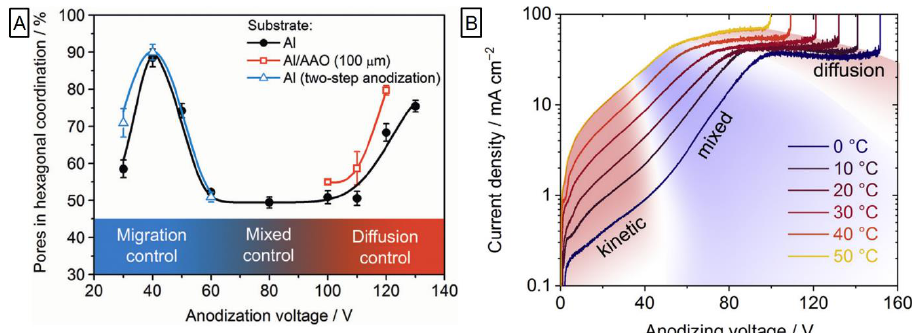
Figure 6. Anodization potential influence on degree of self-ordered growth and voltage/temperature dependent formation kinetics of 0.3 M H 2 C 2 O 4 anodization of aluminum. ( A ) Dependence of pore ordering degree during formation of alumina structure with highlighted regions of different growth kinetics. Reprinted (adapted) with permission from [111]. Copyright 2017 Elsevier. ( B ) Linear staircase voltammograms with highlighted growth kinetics. Reprinted (adapted) with permission from [113]. Copyright 2019 Elsevier.